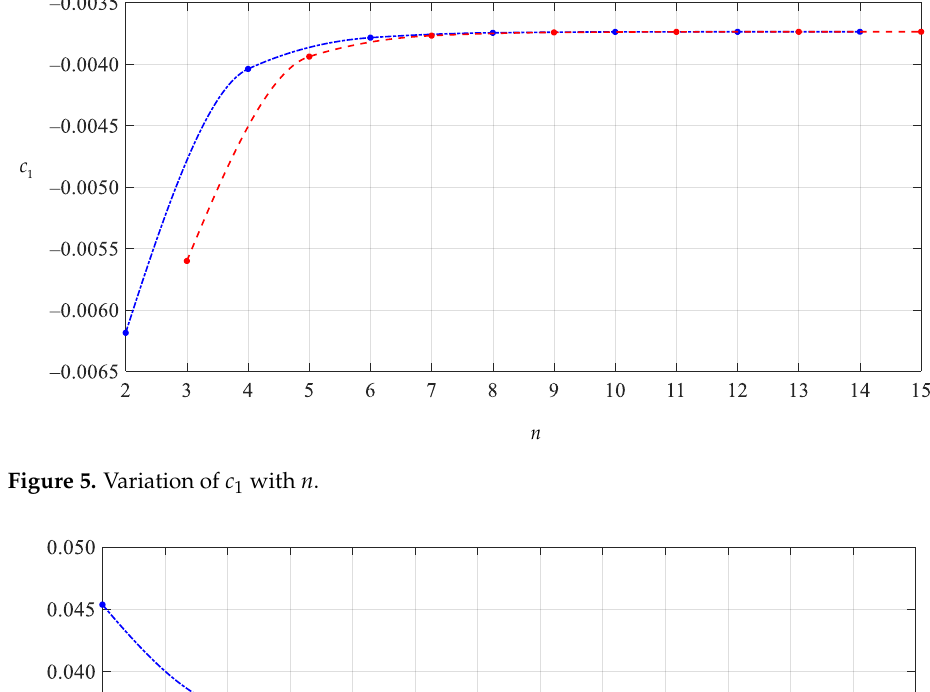
Figure 4. Variation of c 0 with n .